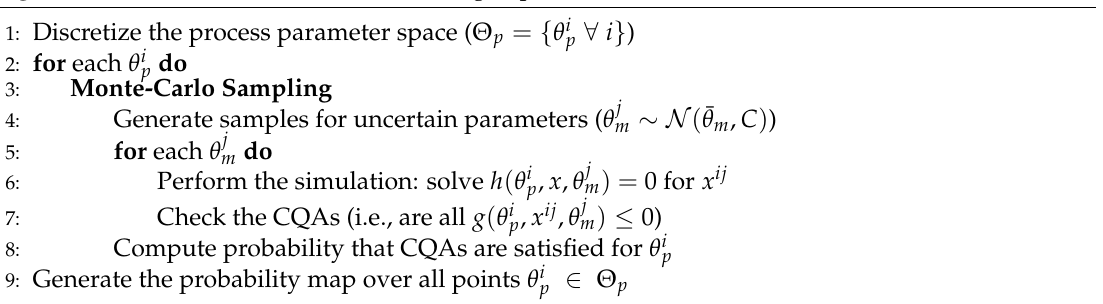
Algorithm 1 Monte-Carlo Probabilistic Design Space